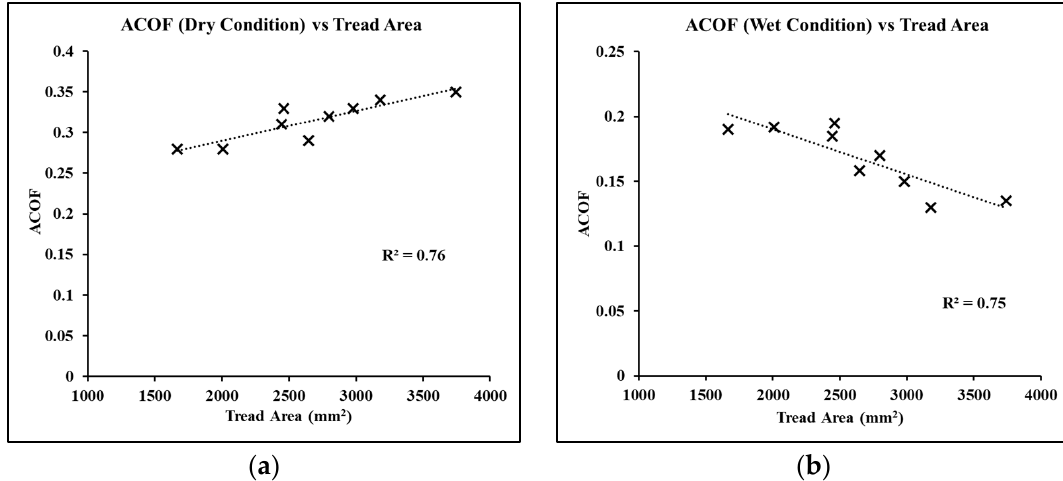
Figure 11. Effect of tread area on ACOF in: ( a ) dry conditions and ( b ) wet conditions. In wet slipping conditions, the effect of the tread area on the fluid pressure and mass flow rate was analyzed by estimating the correlations between them (Figure 12). The tread areas were observed to be moderately correlated (R 2 = 0.52) for the fluid pressure and weakly correlated (R 2 = 0.31) for the mass flow rate (Figure